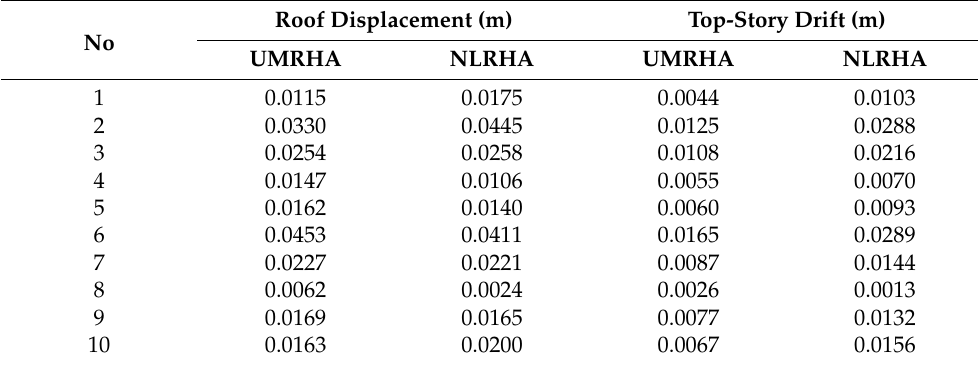
Table 12. Peak values regarding roof displacement and top-story drift of RES open top-story frame to the selected ground